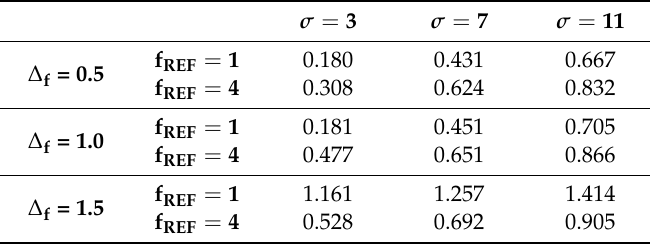
Table 5. Sensitivity analysis with simulated data, effect of atmosphere-like disturbances. RMSE (in radians) of the demodulated unwrapped phase at three different σ values (logistic gradient).